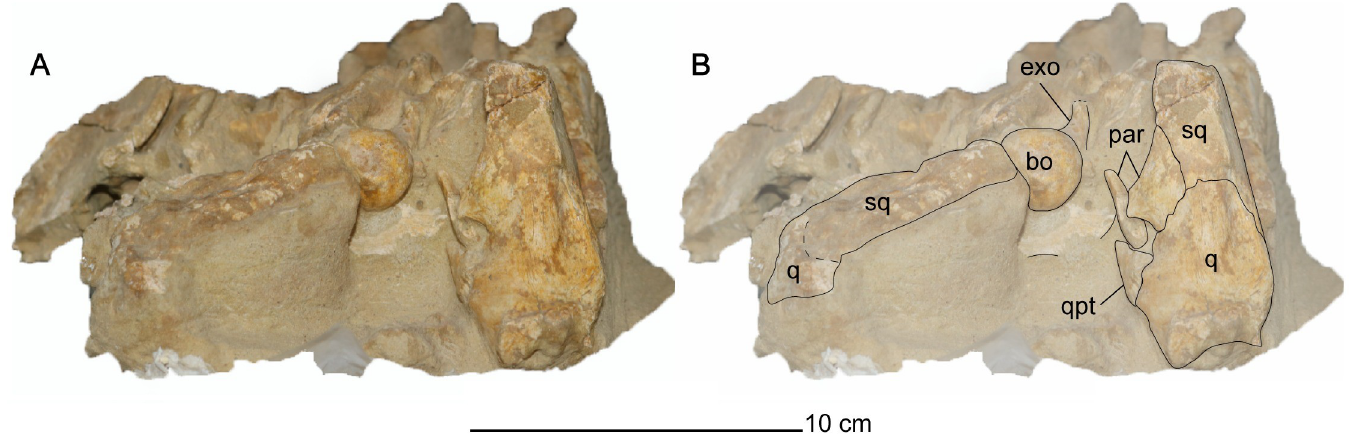
Fig 4. Exposed occiput of Cardiocorax mukulu (MGUAN PA278) cranium. A. Occiput without labels. B. Occiput elements